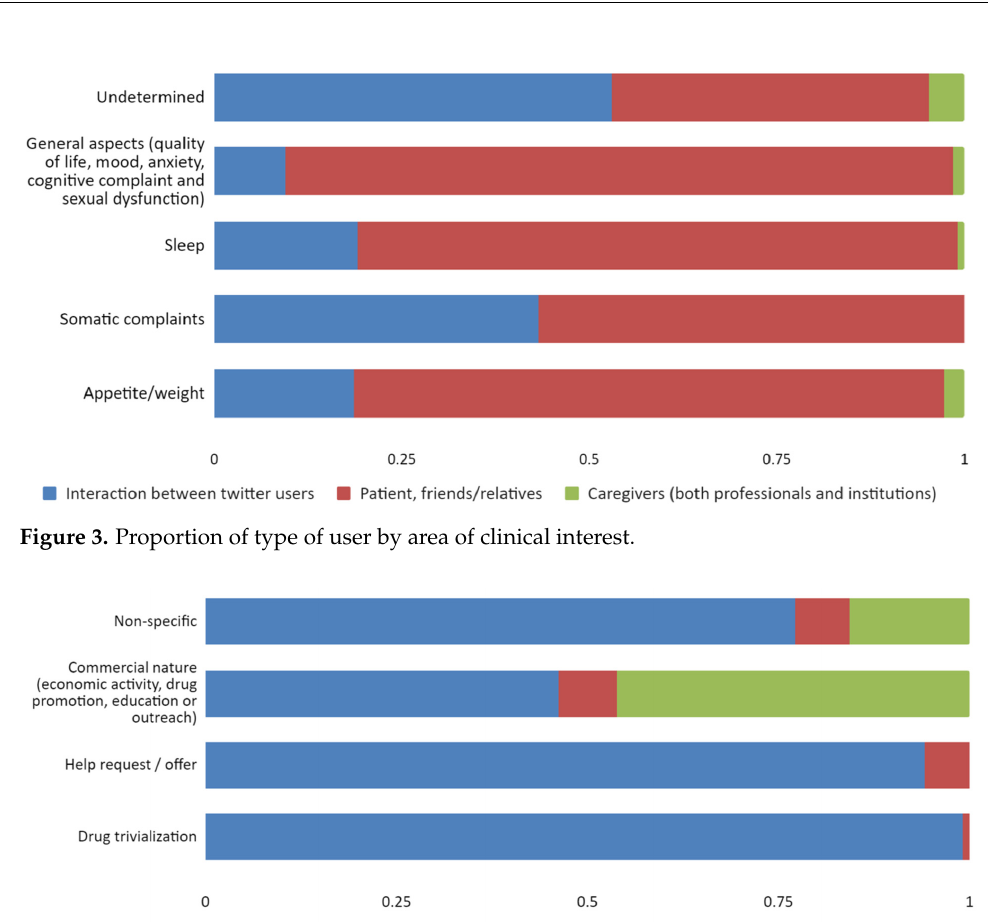
Figure 2. Proportion of type of user by considered aspects of tweets.